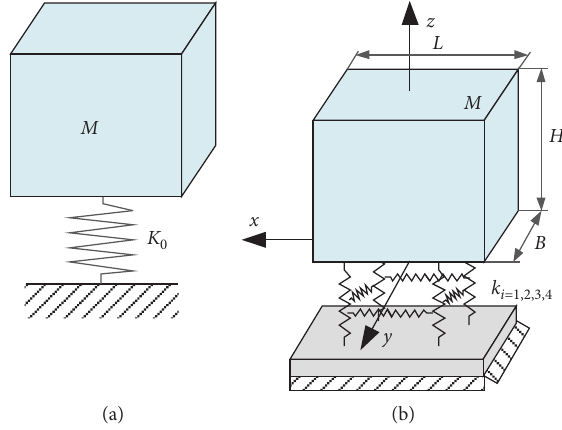
Figure 2: Simplified model for rock